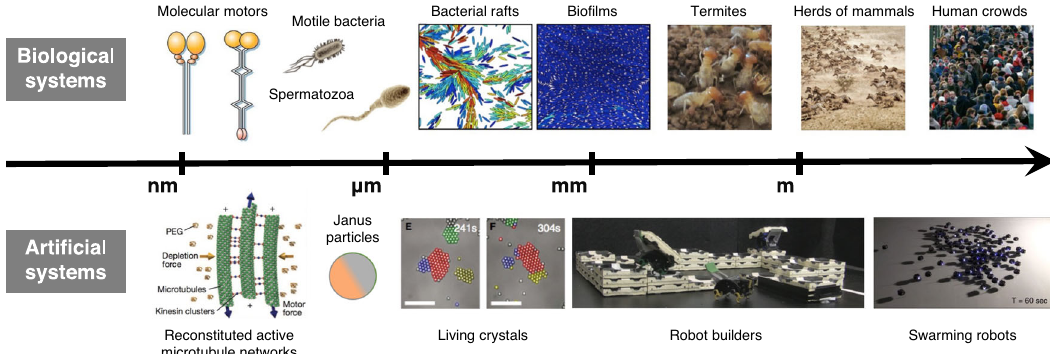
Fig. 1 Examples of active matter systems. Overview of active matter systems on all length scales, ranging from nanoscopic molecular and colloidal systems to swarms of animals or robots, and even to human crowds. Despite their seemingly large differences, all these systems exhibit striking similarities regarding their emergent behaviours. Being out of thermodynamic equilibrium, active particles can explore complex forms of dynamical self-organisation and exhibit intricate interplays between single-particle properties and collective behaviours that are impossible at thermodynamic equilibrium. Examples of biological active matter systems (from left to right): biomolecular motors (Reprinted by permission from Springer Nature Customer Service Centre GmbH: Nature, M. Schliwa and G. Woehlke 106 , Copyright 2003 Springer Nature); microorganisms such as motile bacteria and spermatozoa (Reprinted fi gure with permission from C. Bechinger et al. 3 . Copyright 2016 by the American Physical Society); bacterial rafts and bio fi lms (Reprinted from H. Jeckel et al. 107 ; use permitted by authors of original publication); insects such as termites (From J. Werfel et al. 108 . Reprinted with permission from AAAS); herds of mammals and human crowds (Reprinted from T. Vicsek and A. Zafeiris 6 , Copyright 2012, with permission from Elsevier). Examples of arti fi cial active matter systems (from left to right): reconstituted active microtubule networks (Reprinted by permission from Springer Nature Customer Service Centre GmbH: Nature, T. Sanchez et al. 109 , Copyright 2012 Springer Nature); Janus particles; living crystals (From J. Palacci et al. 110 . Reprinted with permission from AAAS); robotic builders (From J. Werfel et al. 108 . Reprinted with permission from AAAS); swarming robots (Reprinted from Rubenstein et al. 111 , Copyright 2014, with permission from